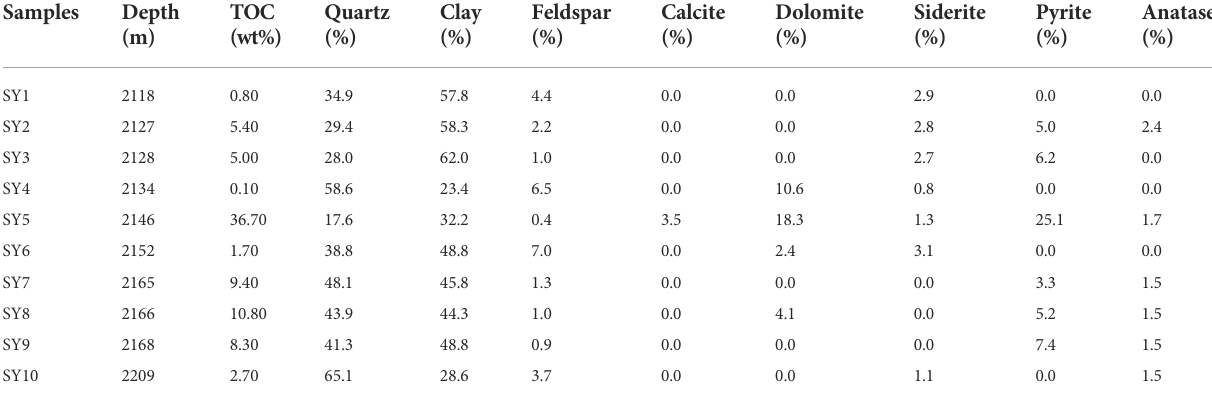
TABLE 1 Geological information and major mineral composition of shale